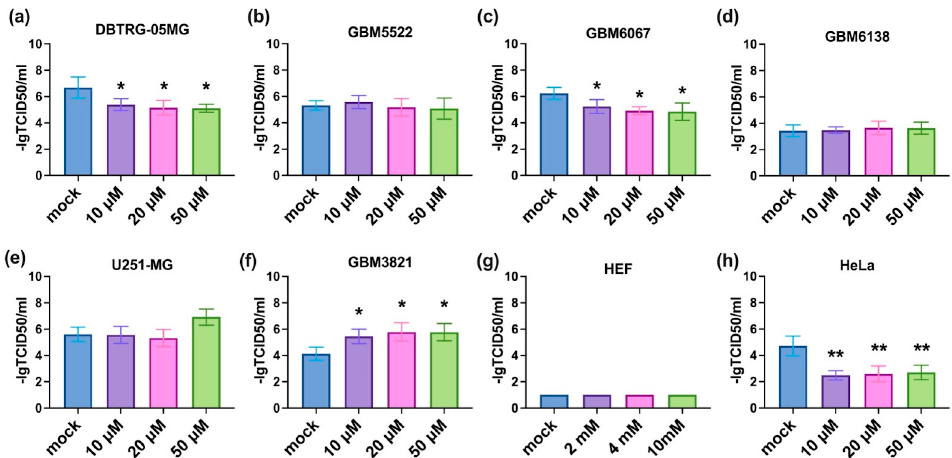
Figure 5. Oncolytic activity of CVB5 towards glioblastoma cells in the presence of phenformin decreased in DBTRG-05MG ( a ), GBM6067 ( c ), and HeLa ( h ), and increased in GBM3821 ( f ). In GBM5522 ( b ), GBM6138 ( d ), U251-MG ( e ), and HEF ( g ) cells it did not affect oncolytic activity of CVB5. Cells were seeded 24 h before treatment with 10, 20, and 50 µM phenformin and simultaneous infection with CVB5 at MOIs of 0.001–1000. Viability was determined using CellTracker method 48 h later, * p ≤ 0.05, ** p ≤ 0.01.